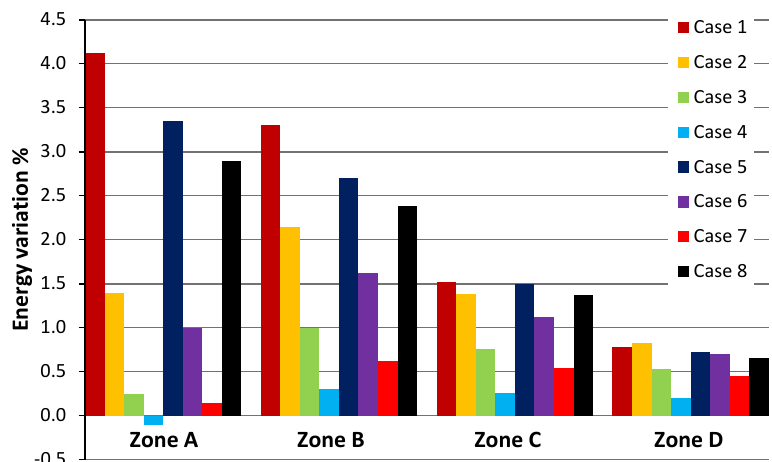
Figure 11. Energy percentage change in zones A, B, C and D.